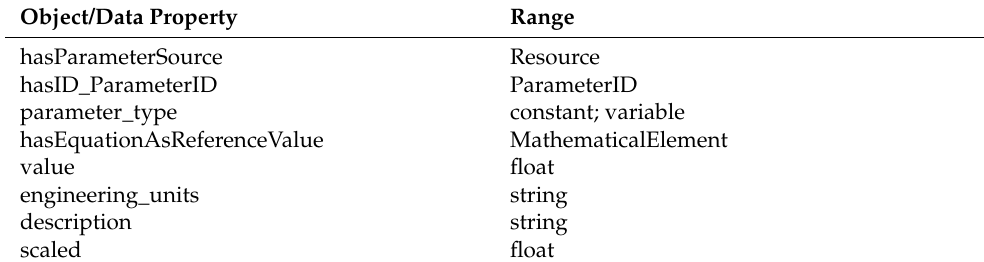
Table 10. Data properties from EOP within the Polymer process